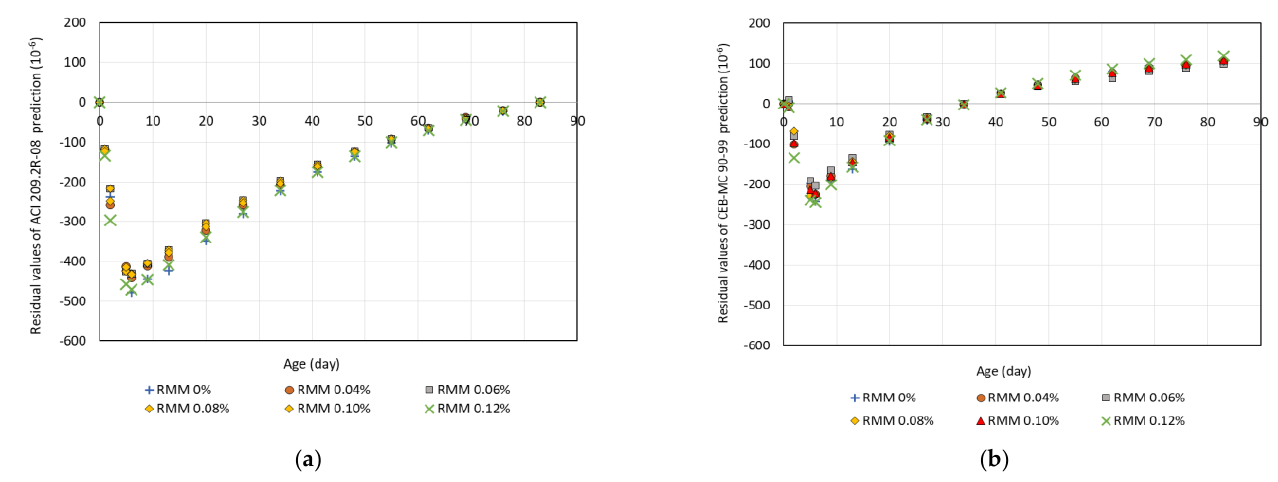
Figure 7. Evaluation of the ACI 209.2R-08 ( a ) and CEB-MC 90-99 ( b ) models by best fit line method.